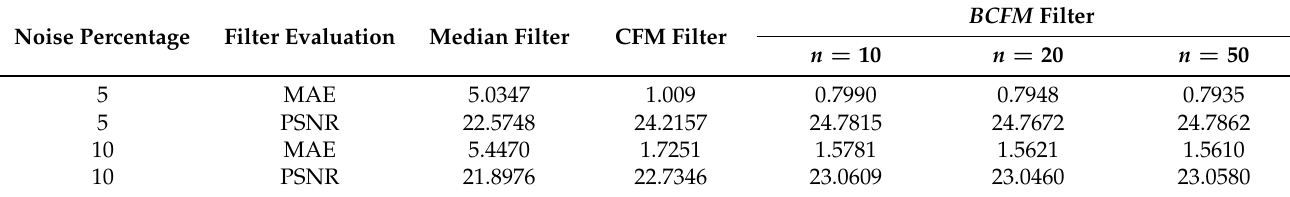
Table 1. Comparison of the performance of noise reduction filters for the COVID-19